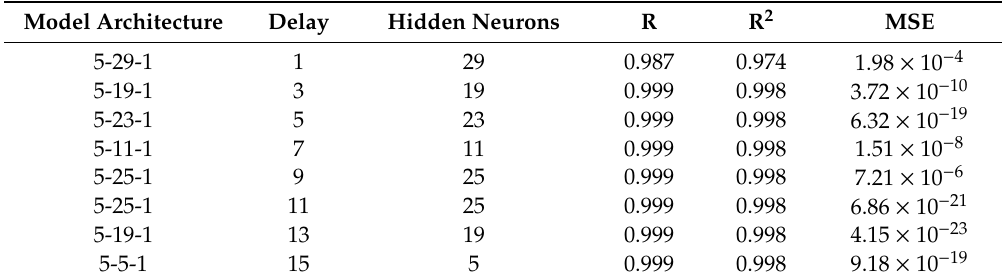
Table 3. Optimized hidden neuron obtained using data for Thailand.